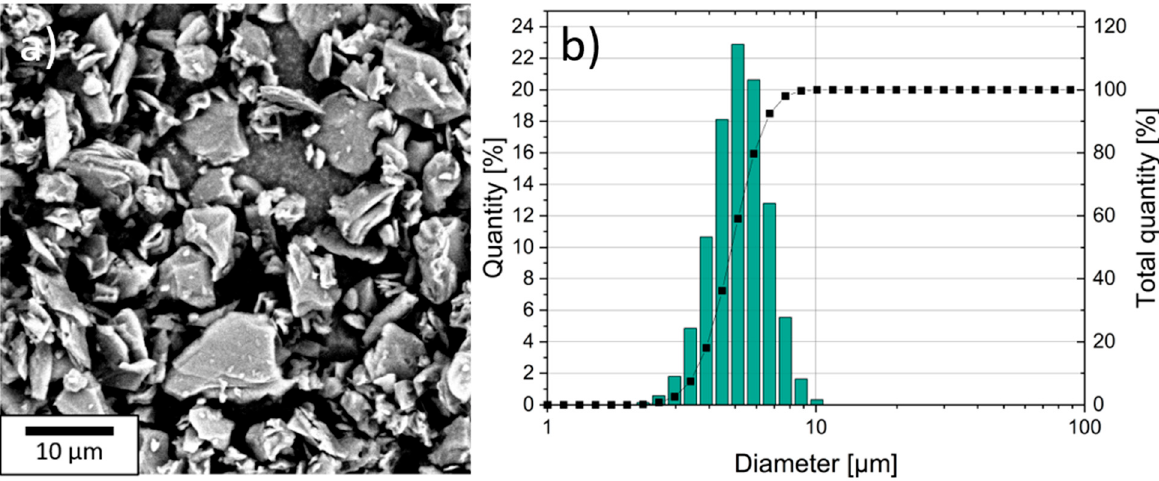
Figure 1. Scanning electrode microscope (SEM) image of the flake-like graphite ( a ) and particle size distribution ( b ).